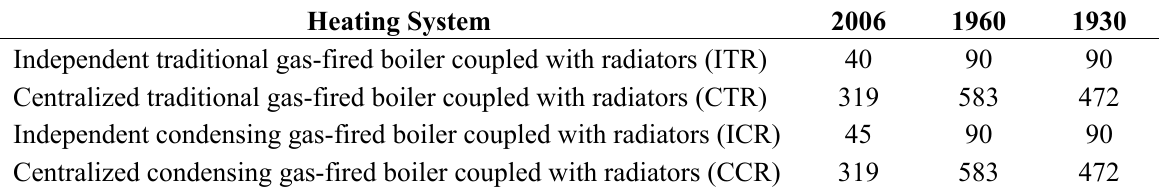
Table 5. Electric pumps consumption [W] for space heating for the different construction